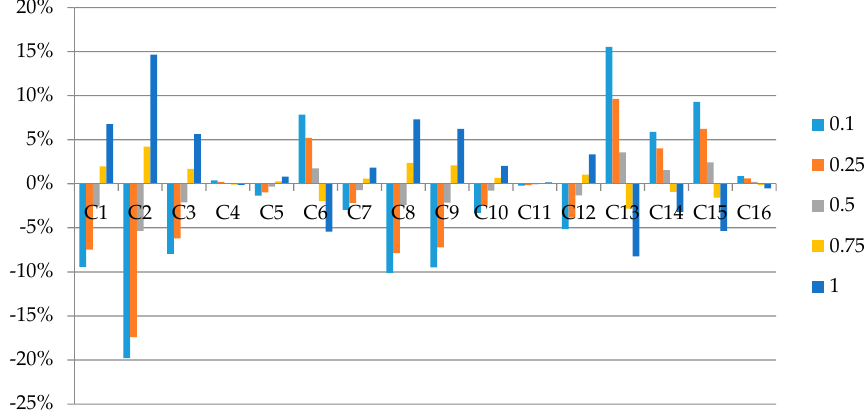
Figure 10. The impact of individual factors on the other factors.